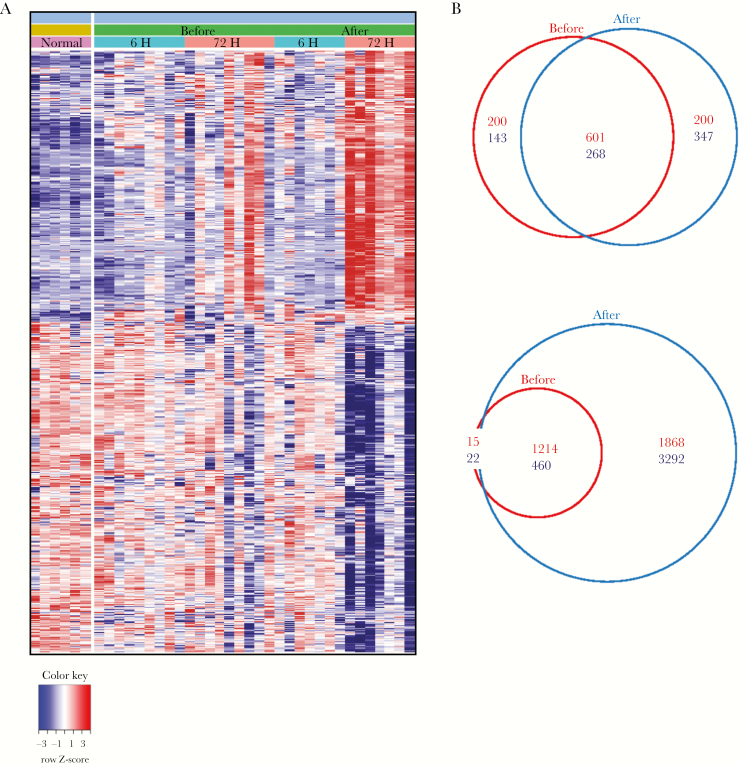
Transcriptomic analysis of varicella zoster virus (VZV) antigen-challenged skin before and after Zostavax vaccination. Punch biopsy specimens (diameter, 3 mm) were collected from older individuals before and after vaccination at 6 and 72 hours after VZV antigen challenge (n = 9 before; n = 7 after). Unchallenged skin punch biopsy specimens were collected from an additional group of volunteers (n = 6). Total skin RNA was isolated, amplified, and hybridized to Affymetrix Human Genome U133 2.0 plus arrays. A, Heatmap showing the relative expression of differentially expressed genes (DEGs) between VZV antigen–challenged and normal unchallenged skin before (left panel) and after (right panel) vaccination at a fold change of >2 and a false-discovery rate of >0.05. (B) Venn diagrams showing numbers of DEGs at 6 hours (top) and 72 hours (bottom) following VZV antigen challenge, compared with normal unchallenged skin. Upregulated genes are shown in red, and downregulated genes are shown in blue.